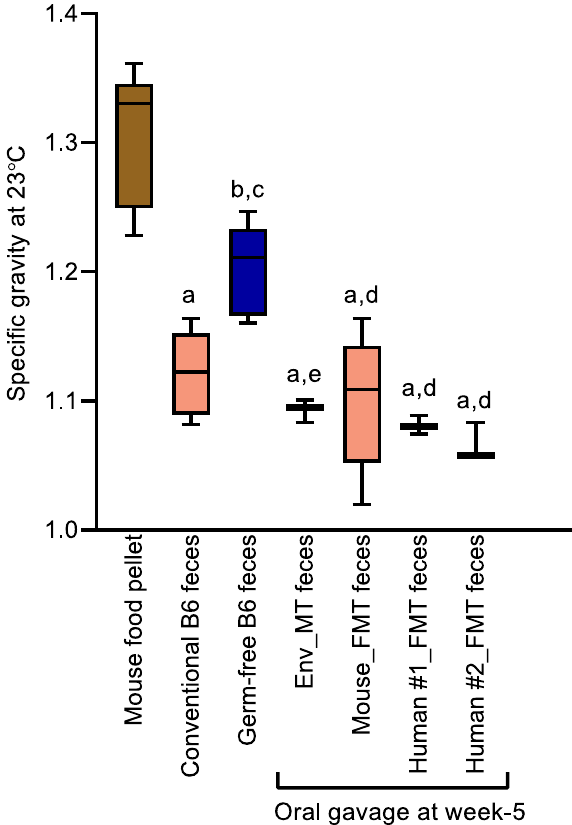
Figure 5. Specific gravities of feces. Specific gravity of the mouse food pellet, germ-free and gut-colonized (conventional, Env MT, mouse FMT and human FMT) mice fecal samples measured using pycnometer at 23 °C. Ordinary one-way ANOVA was performed for comparisons between the samples. a p < 0.0001 versus Mouse food pellet, b p < 0.01 versus Mouse food pellet, c p < 0.05 versus Conventional B6 feces, d p < 0.01 versus Germ-free B6 feces and e p < 0.05 versus Germ-free B6